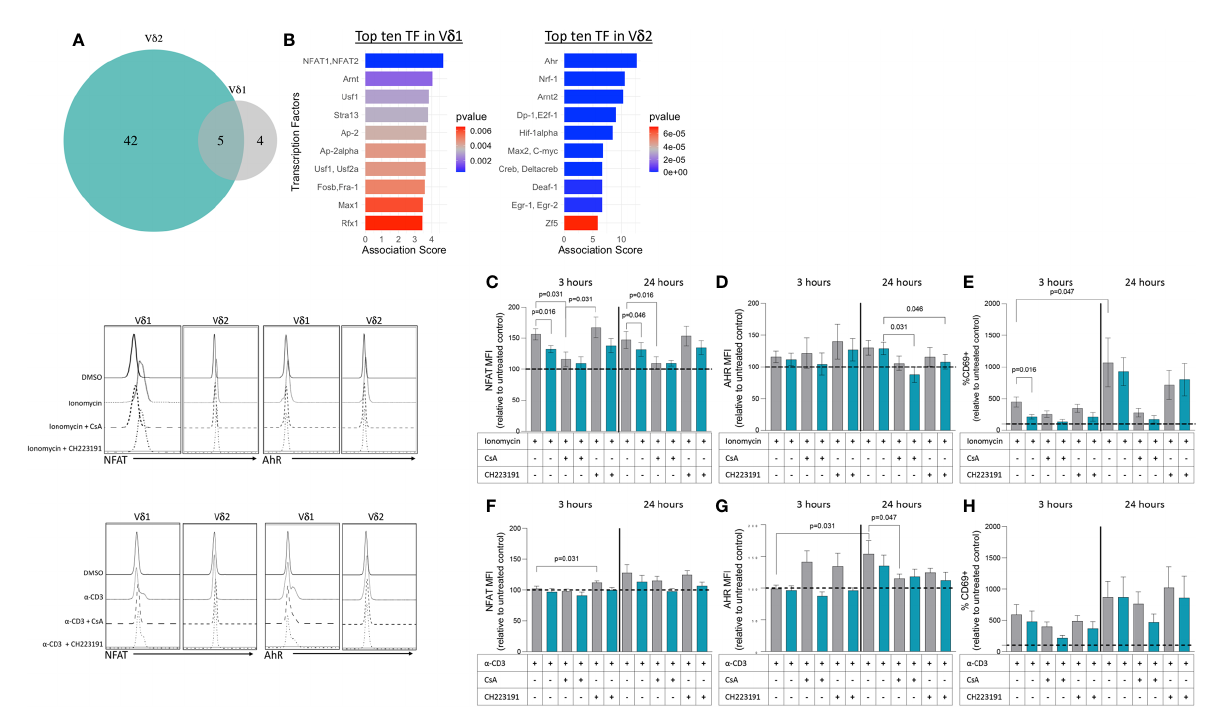
FIGURE 5 Transcription factors associated with upregulated genes within V d 1 and V d 2 T cell subsets. (A) The Predicting associated transcription factors from annotated af fi nities (PASTAA) software revealed a list of four transcription factors (TFs) associated with V d 1 T cells, fi ve TFs common to both subpopulations, and 42 associated with V d 2 T cells. (B) Top TFs associated with V d 1 and V d 2 T cells, are shown. Upon stimulation with ionomycin (C) NFAT (D) AhR and (E) CD69 or a -CD3 monoclonal antibody (F) NFAT (G) AhR and (H) CD69 expression were analyzed in V d 1 and V d 2 T cells after 3 and 24 hours of exposure in the presence or absence of inhibitors of NFAT (cyclosporine A, CsA) or AhR (CH223191). Wilcoxon Rank-Sum test were used to compare the data. Normalized mean fl uorescence intensity (MFI) and frequency of CD69 expression to the untreated or DMSO controls are presented.